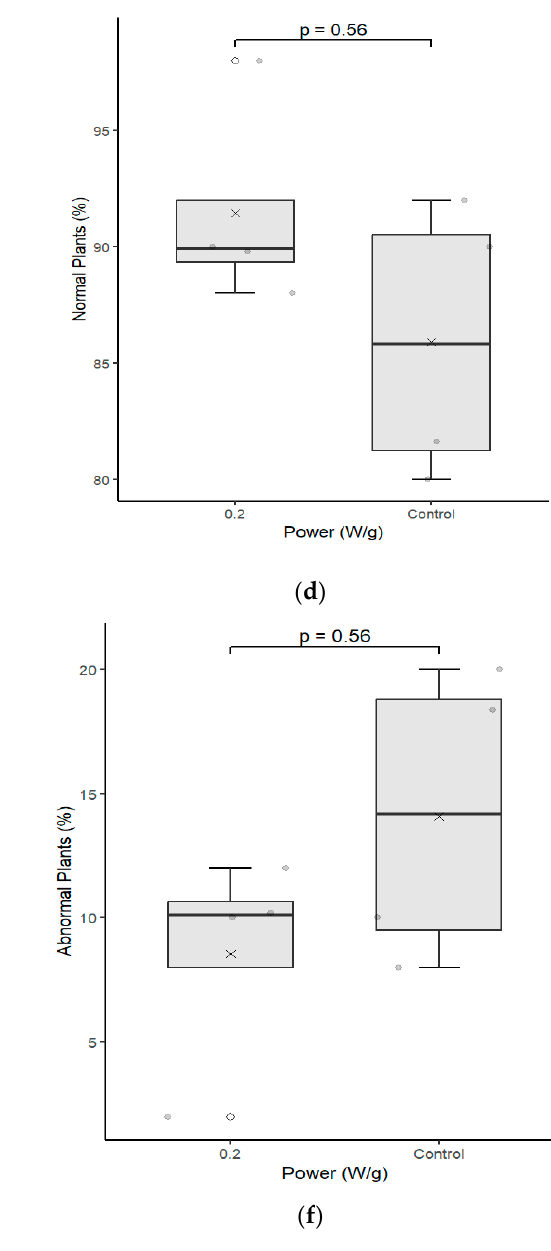
Figure 3. Germination pattern test between the control group seeds and those that underwent magneto-priming (0.2 W/g). The left, figures ( a , c , e ), are related to cultivar C01; the right, figures ( b , d , f ), refer to cultivar C02. The differences were estimated by the Mann–Whitney test at a significance level of 0.05. The media, data, and p value are represented in the figures for the x, dots, and letter p , respectively.